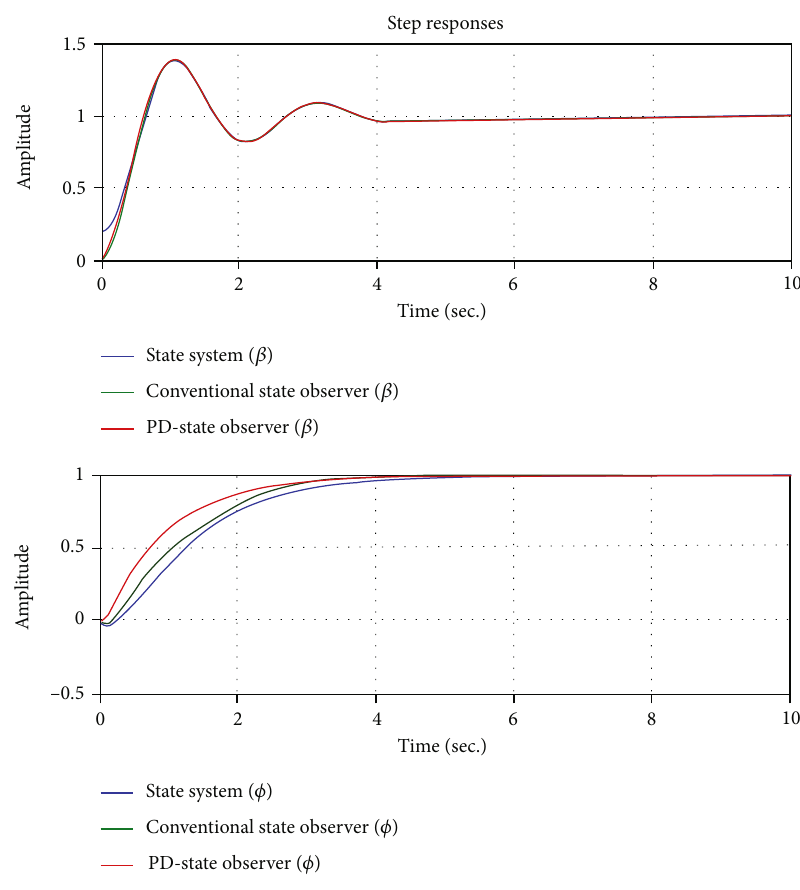
Figure 6: Simulations of state observer with α = 50 I